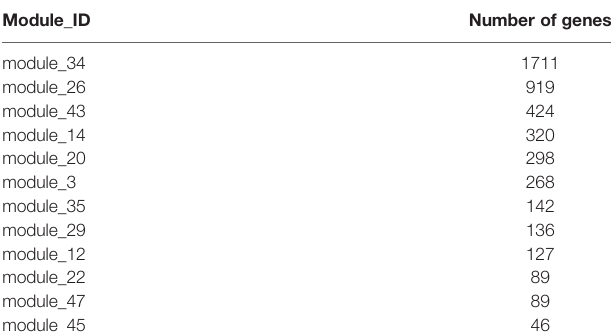
TABLE 2 | Information of gene modules identi fi ed by